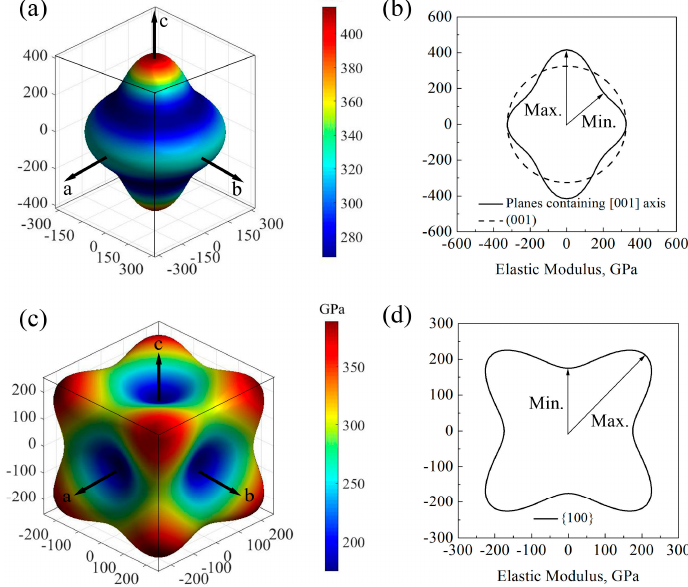
Figure 2. Direction dependences of elastic moduli: ( a ) wurtzite GaN; ( b ) projections on main crystal planes of wurtzite GaN, where the solid line denotes planes containing [001] axis and the dash line is plane [001]; ( c ) zinc-blende GaN; and ( d ) the projection on planes {111} of zinc-blende GaN.